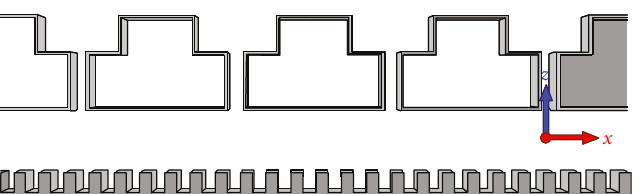
Figure 3: Side view of the simulation model of the perturbed structure. Four elements are cascaded in the X direction and the element is periodic.